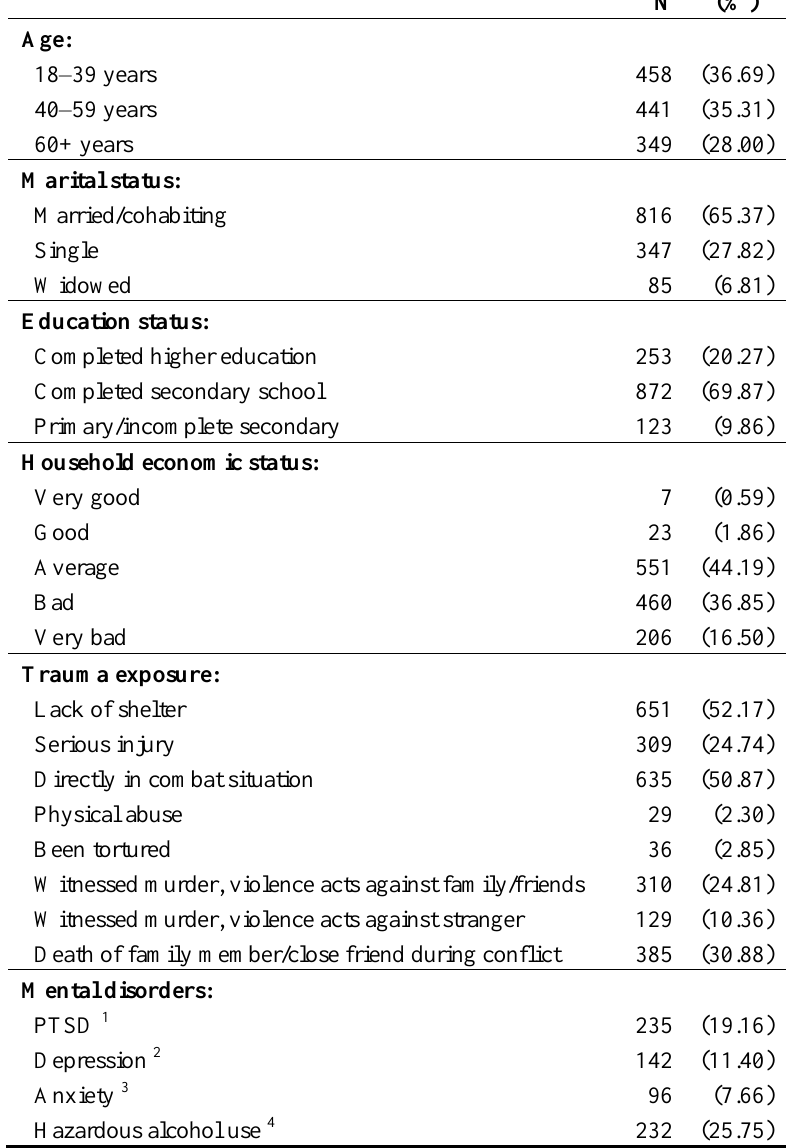
Table 1. Sample characteristics (men only, N =